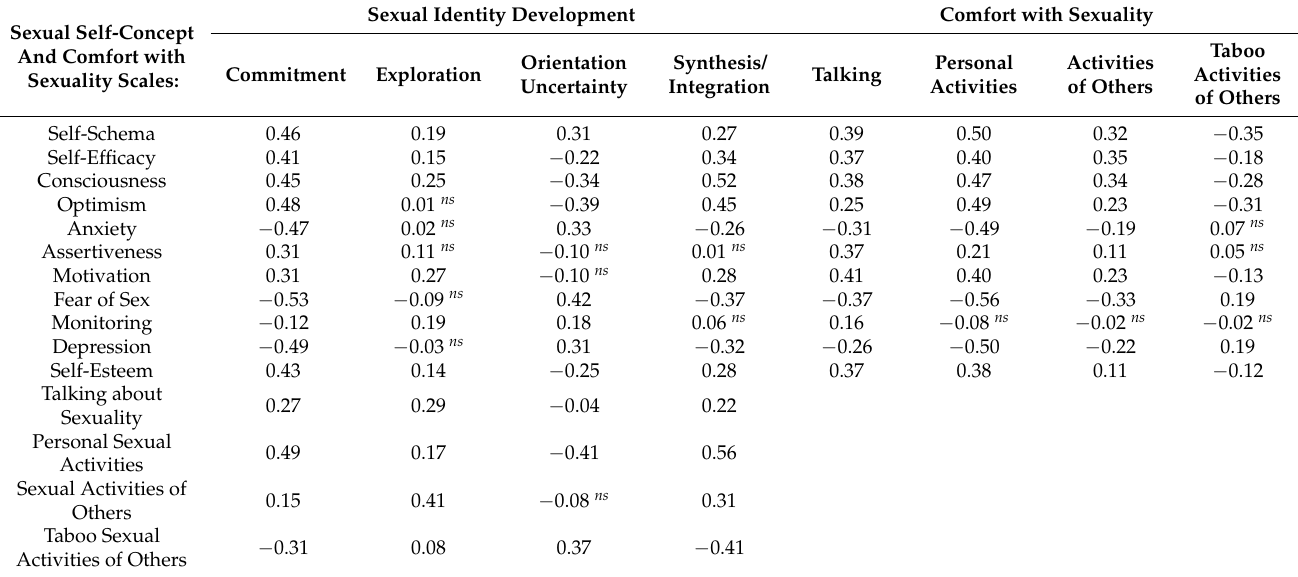
Table 1. Zero-order correlations between Sexual Identity Development domains and Sexual Self- Concept and Sexual Comfort Measures ( N = 304–307).